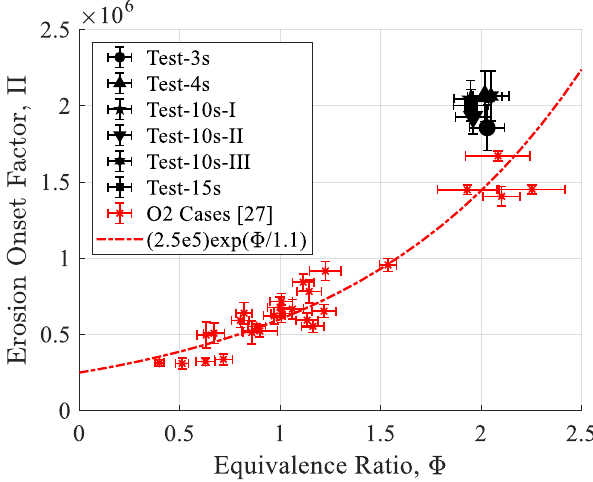
Figure 12. Erosion onset factor is larger when using N 2 O as the oxidizer rather than O 2 .